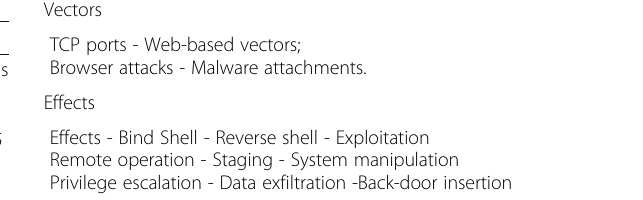
Table 11 ADFA-WD Vectors and